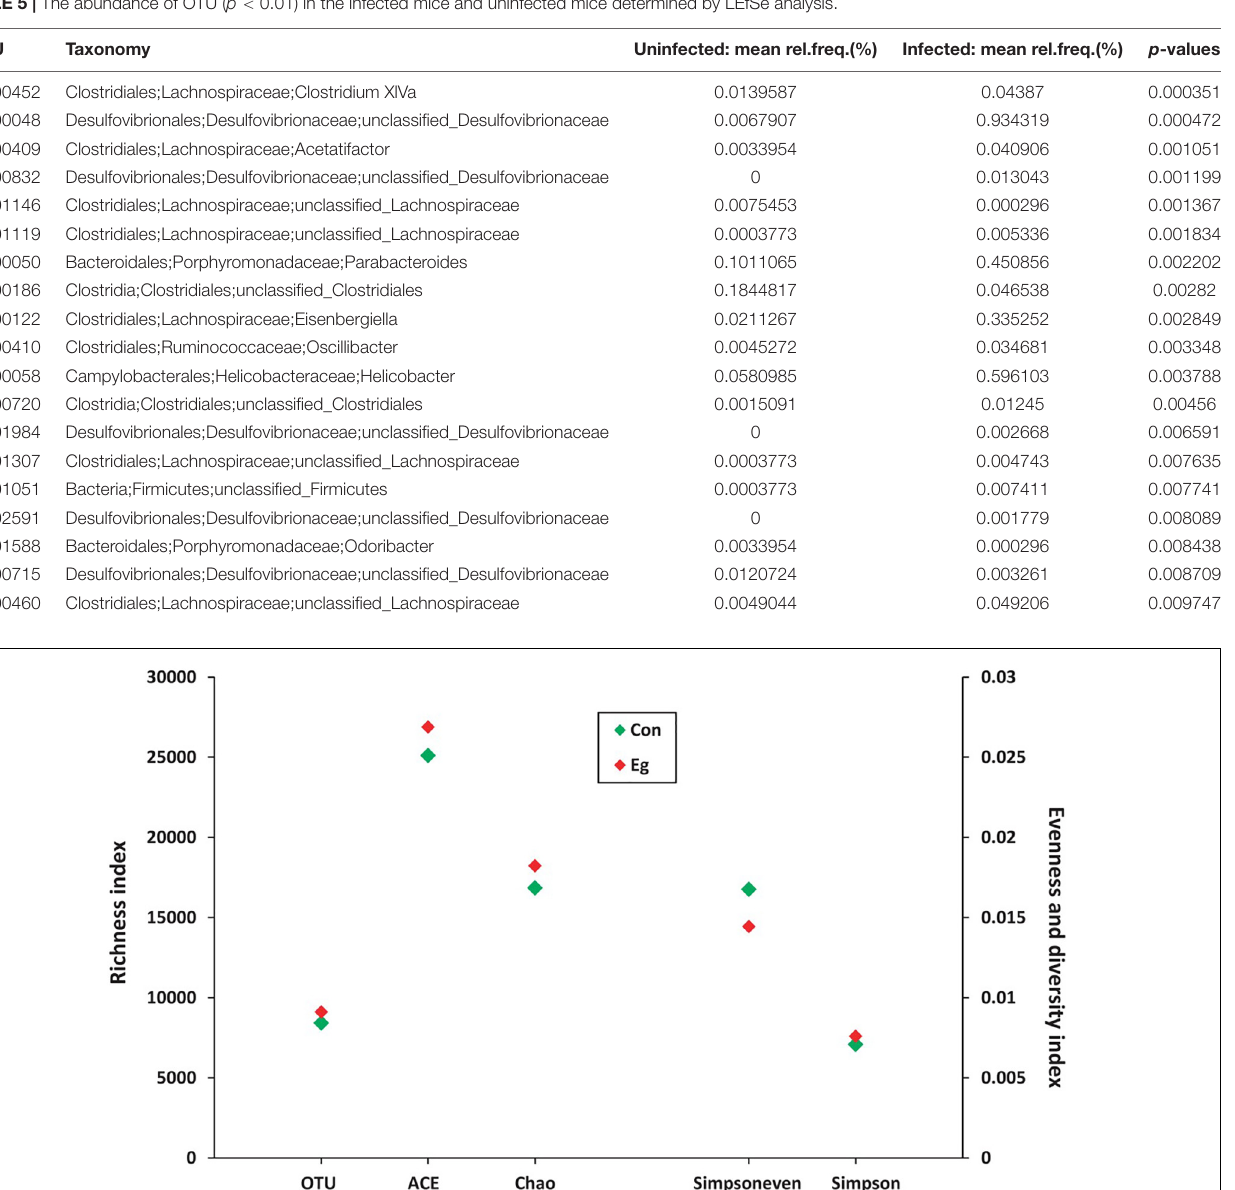
Parabacteroides , with most genera remaining unchange. The two genera are in the family Lachnospiraceae . Their increase may impact on human health (Plieskatt et al., 2013), and may be associated with diabetes in mice (Kameyama and Itoh,